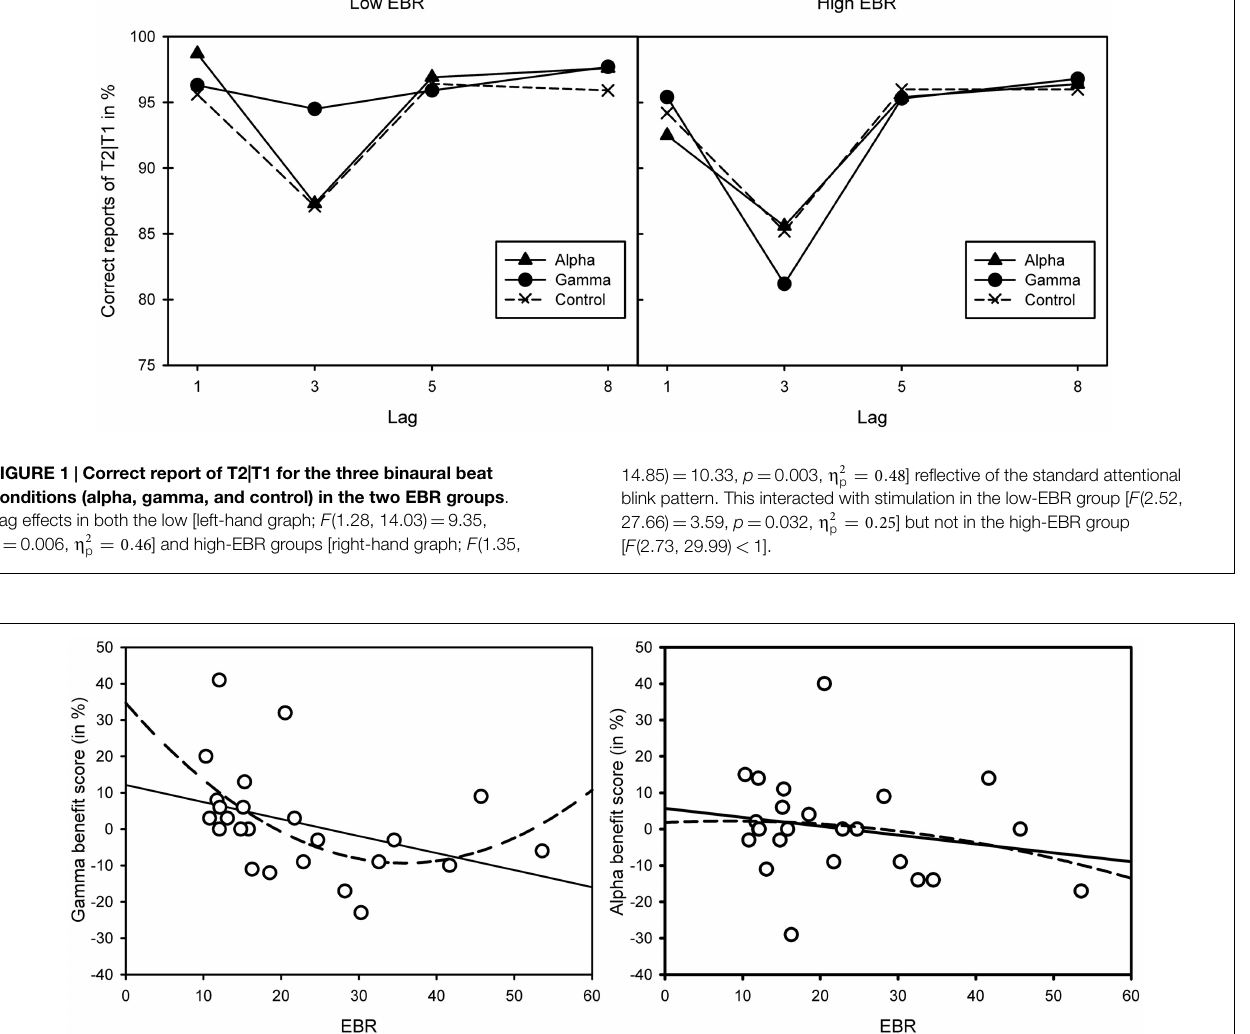
and EBR [right-hand graph – linear: F (1, 22) = 1.03, p = 0.32; quadratic: F (2, 21) < 1] . Benefit scores were calculated by subtracting lag 3 AB performance in the control condition from lag 3 AB performance in the (gamma or alpha) binaural beat